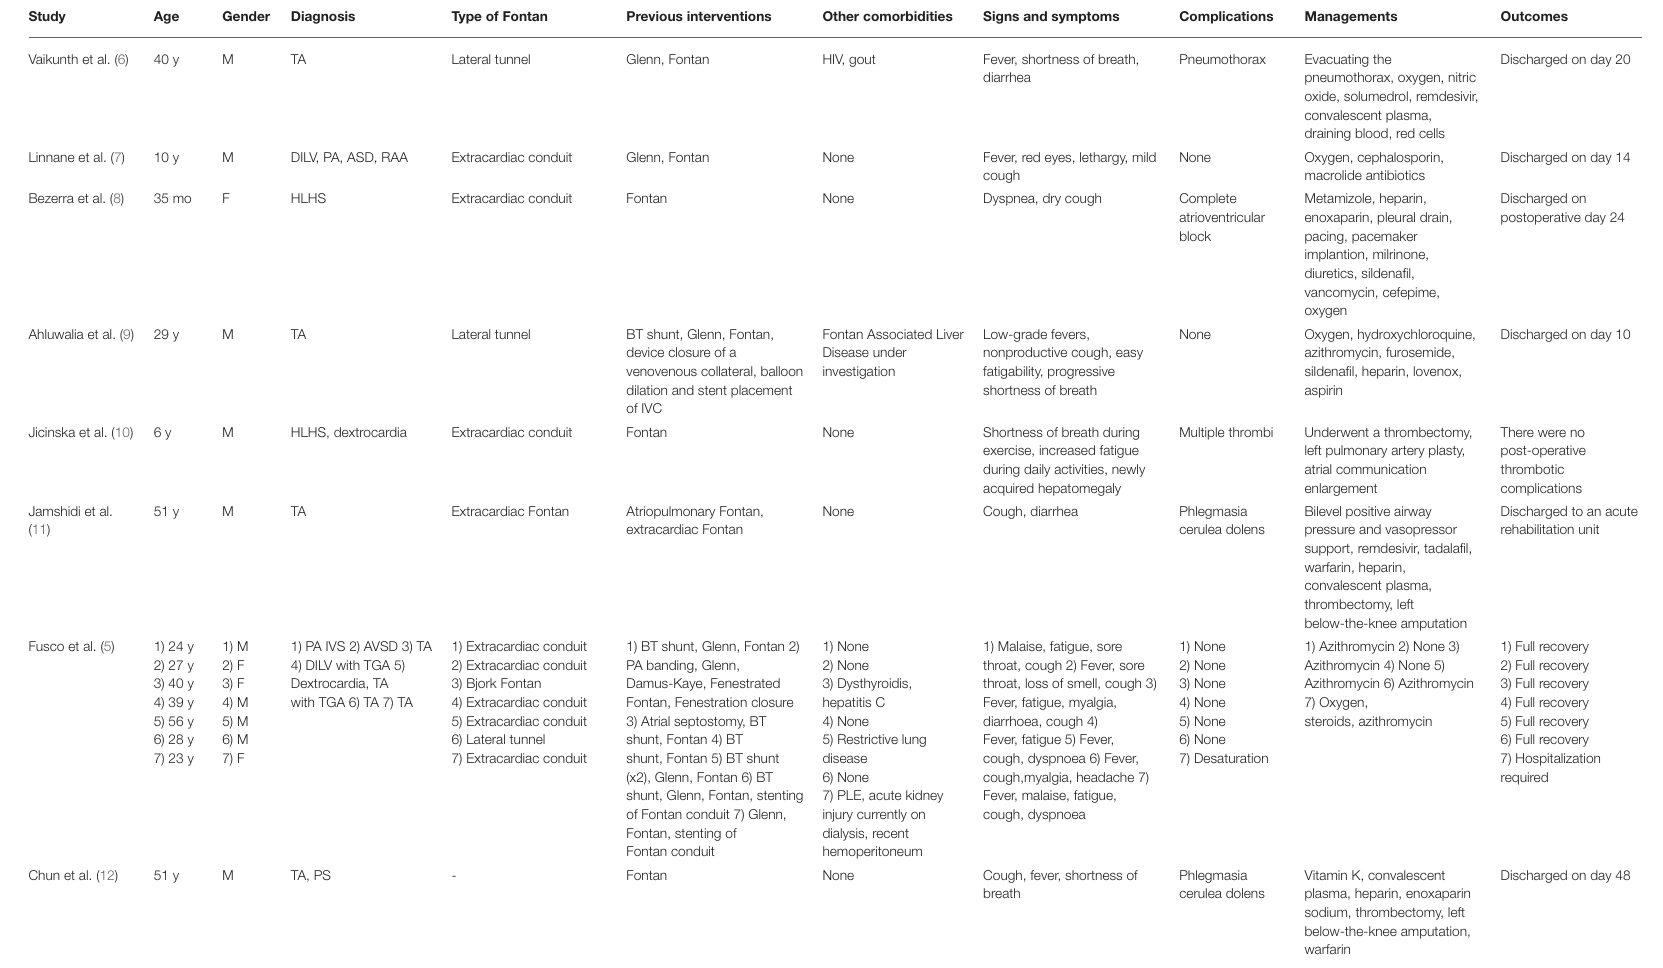
F, female; ASD, atrial septal defect; AVSD, atrioventricular septal defect; DILV, double inlet left ventricle; HLHS, hypoplastic left heart syndrome; IVC, inferior vena cava; M, male; PA, pulmonary atresia; PA IVS, pulmonary atresia with intact ventricular septum; PLE, protein losing enteropathy; PS, pulmonary stenosis; RAA, right aortic arch; TA, tricuspid atresia; TGA, transposition of the great